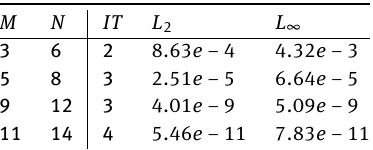
Table 6: The convergence rate of the proposed method to solve example 3.